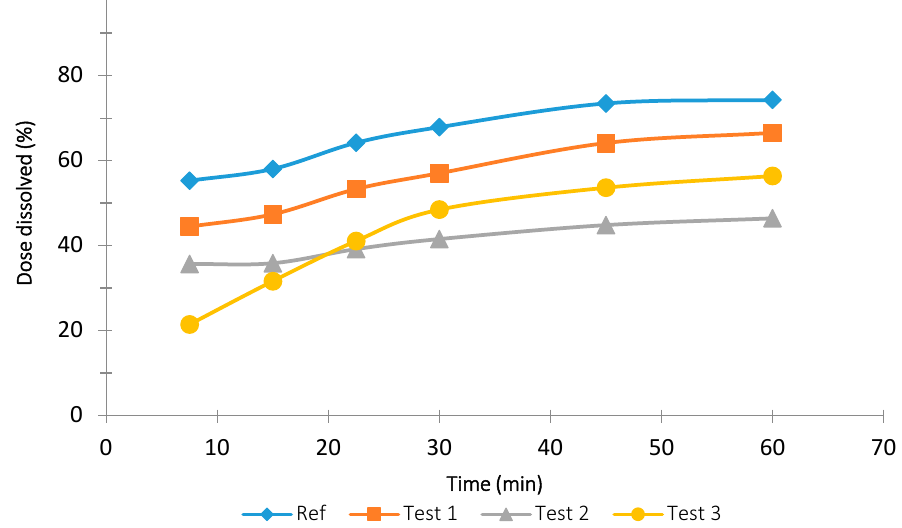
Figure 4. Mean dissolution results and standard deviation obtained with the rotational paddle dissolution equipment at 4.5 pH with 0.2% w / v SDS.